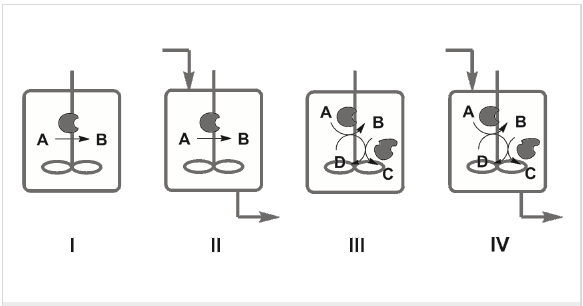
Figure 2: Four generations of biotransformations. I: Single-reaction processes; II: Single-reaction processes in continuous flow; III: Coupled-reaction processes; IV: Coupled-reaction processes in contin- uous